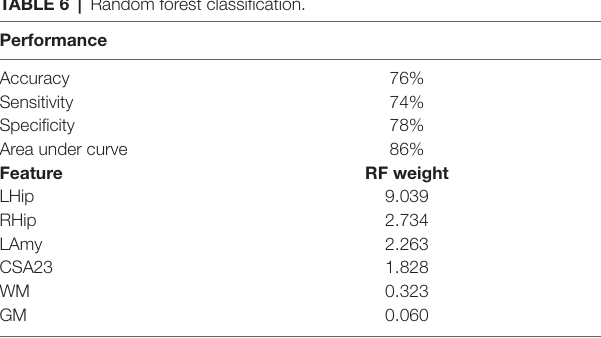
TABLE 6 | Random forest